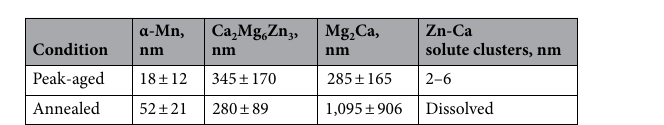
Table 4. Precipitate morphology for the peak-aged and annealed material.